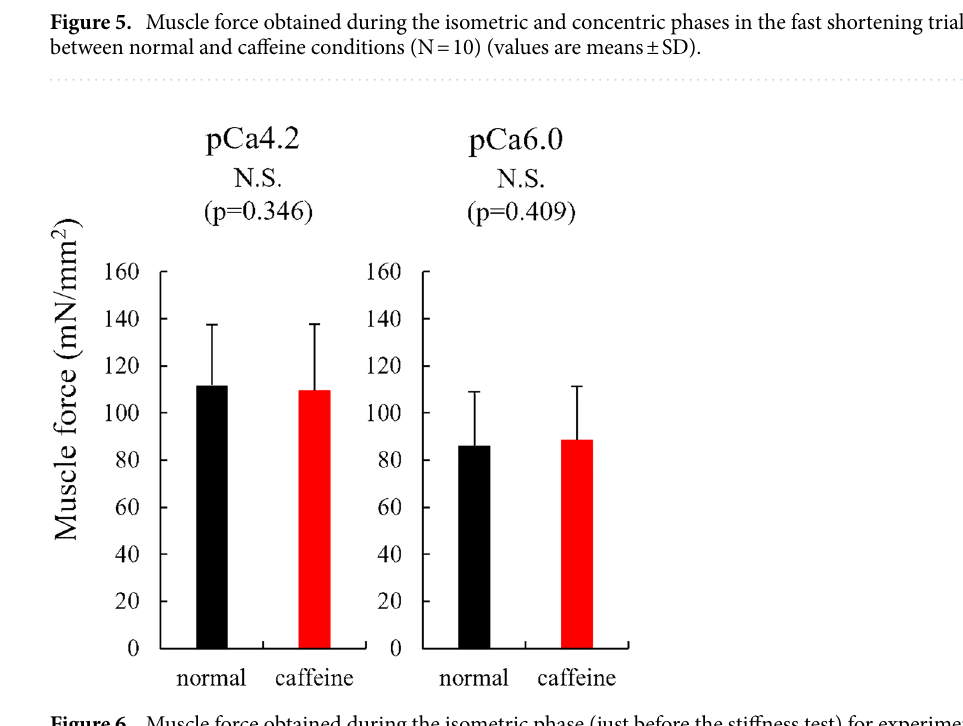
Figure 6. Muscle force obtained during the isometric phase (just before the stiffness test) for experiment 2 between normal and caffeine conditions (N = 9) (values are means ±